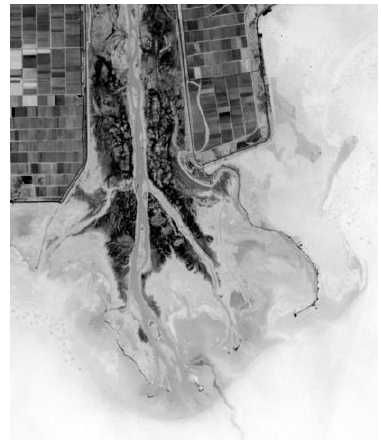
Figure 4b. Axios delta – brightness inversion